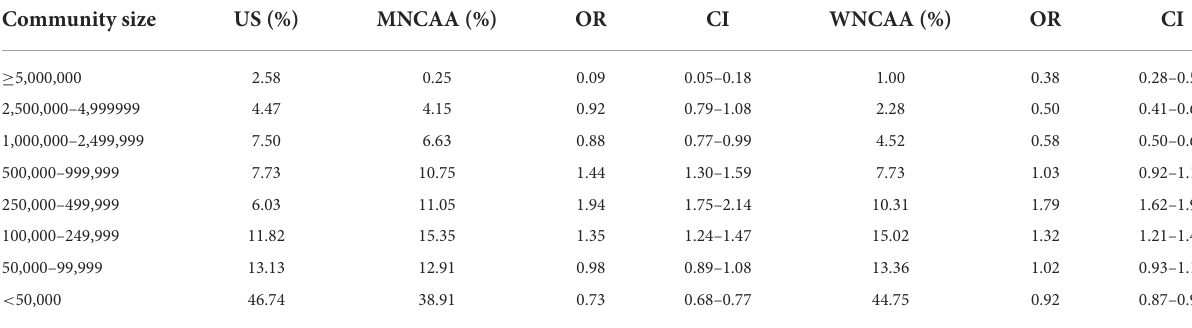
TABLE 1 Odds ratios (ORs) and confidence intervals (CIs) across city size categories for collegiate athletes. Community